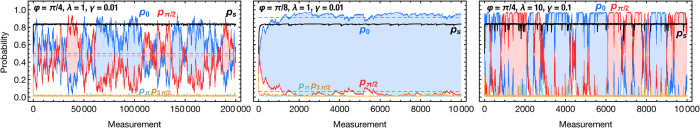
Long-term evolution of the state of a single agent in terms of success probability and the individual probabilities to do one of the four actions.For φ = π/4 (left) the action pair  and  is degenerate with respect to the expected reward. For φ = π/8 (middle), i.e., not exactly between two projectors, the agent measures more often into the direction α = 0. Fluctuations in the measurement probabilities do not necessarily show in the success probability. For comparison, the ensemble averages of 1000 agents after 1000 measurements are given as dashed lines. Larger rewards λ and damping γ (both rescaled by a factor 10) decrease the timescale of the fluctuations while maintaining approximately the same time average (right). The agent jumps between different preferred action and stays for extended times.